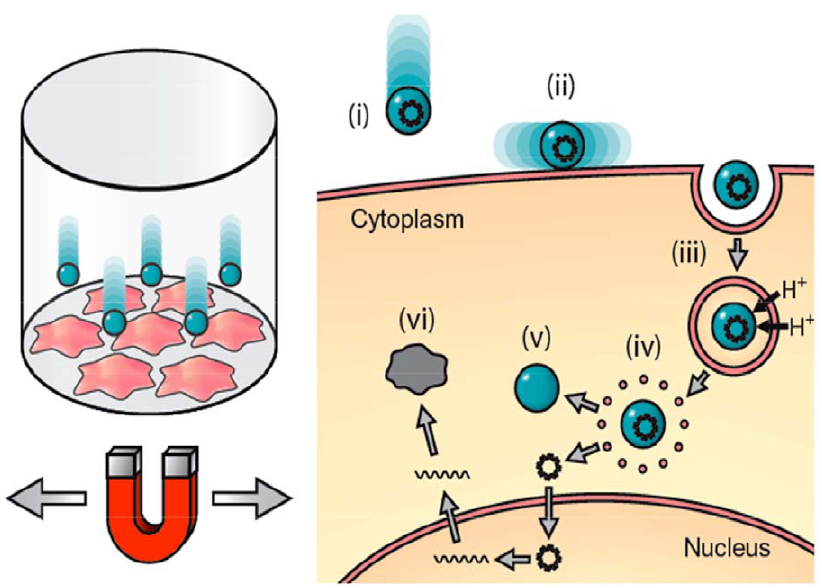
Figure 1. Principle of oscillating nanomagnetic transfection. Short interfering RNA (siRNA) or plasmid DNA is attached to magnetic nanoparticles and incubated with cells in culture (left). An oscillating magnet array below the surface of the cell culture plate pulls the particles into contact with the cell membrane (A) and drags the particles from side-to-side across the cells (B), mechanically stimulating endocytosis (C). Once the particle/nucleic acids complex is endocytosed, proton sponge effects rupture the endosome (D) releasing the nucleic acids (E) which either transcribes the target protein or silences the target genes (F) [3].